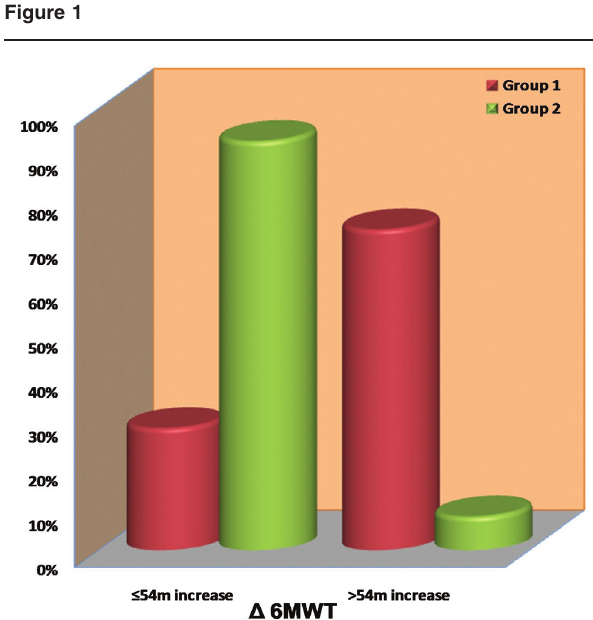
Bar chart shows comparison between group 1 and group 2 regarding Δ 6MWD. 6MWD, 6min walk distance.